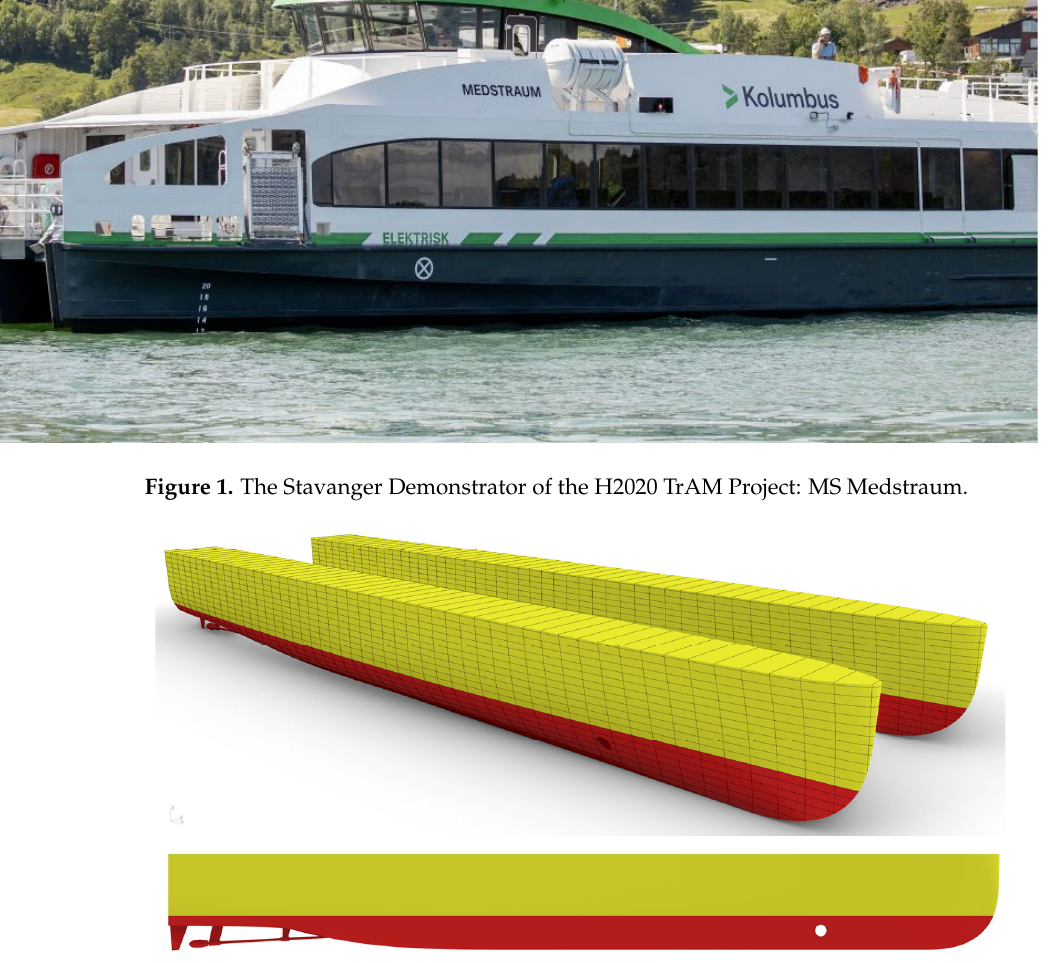
Figure 2. Hull surface in 3-D from the perspective ( upper ) and profile ( lower ) views. Table 1. Principal dimensions of the Stavanger Demonstrator. Dimension Nondim. Nondim. Value Separation